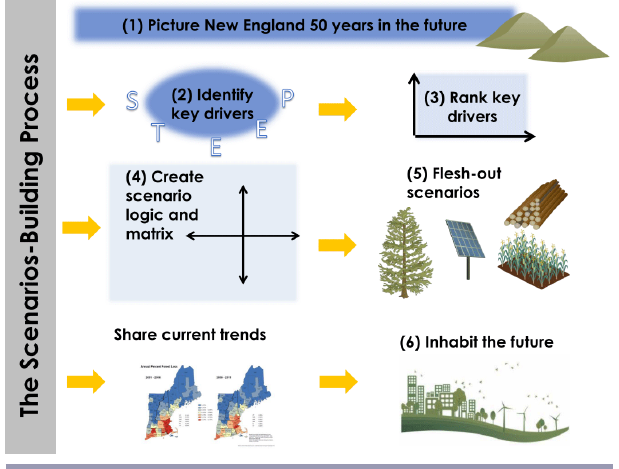
Fig. 1 . Stages in the scenario development process. For additional information about each of the stages refer to